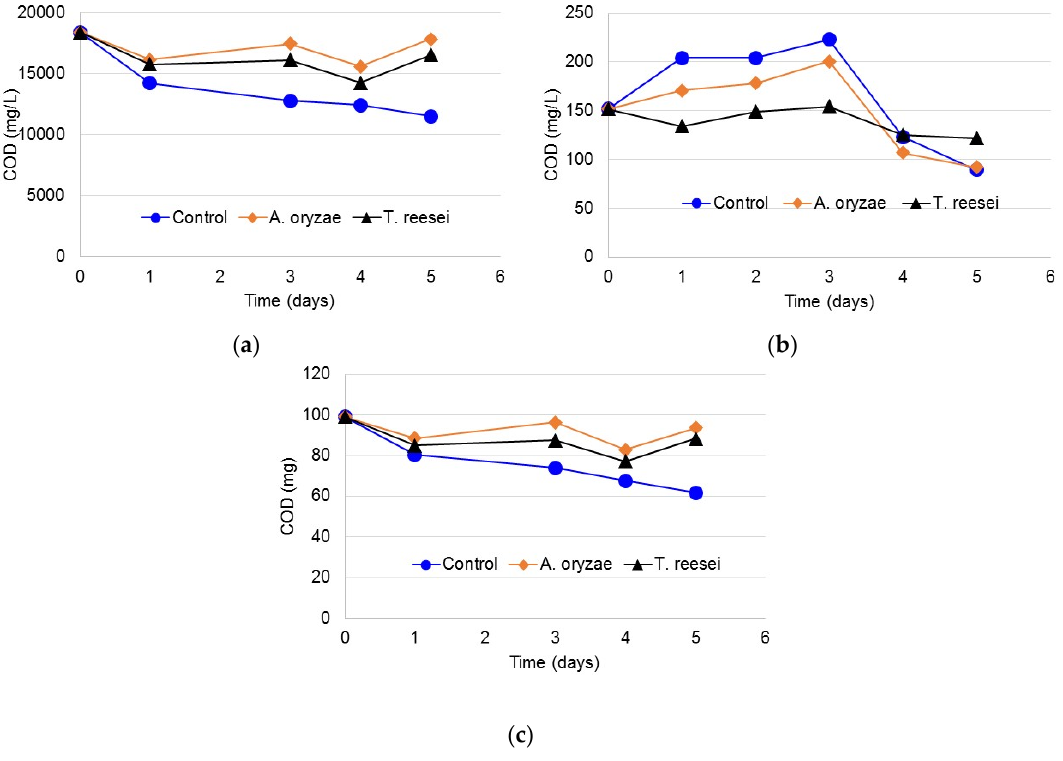
Figure 2. Evolution of COD during the fungal conditioning of activated sludge. ( a ) Particulate COD (biosolids); ( b ) soluble COD (supernatant); ( c ) total COD (particulate + soluble).